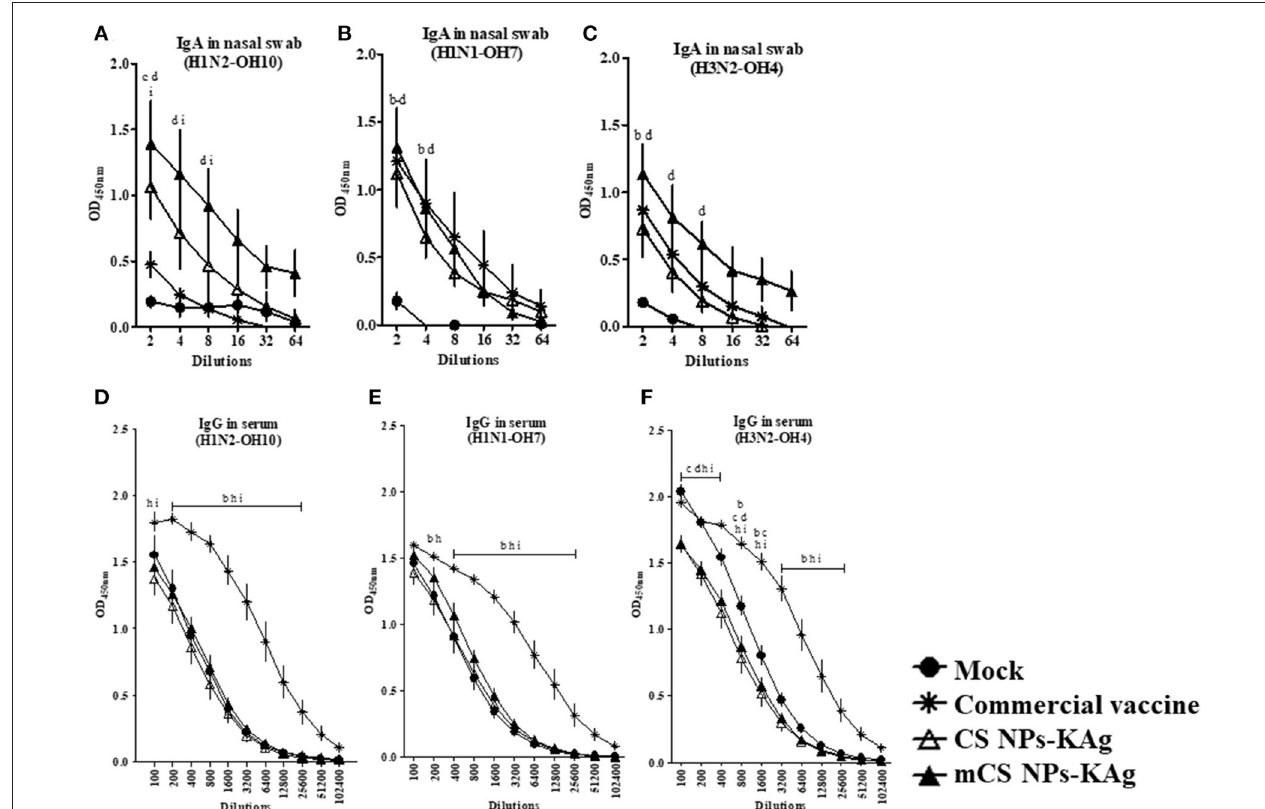
FIGURE 1 | Mannose conjugated CS NPs based influenza (mCS NPs-KAg) vaccine augmented cross-reactive secretory IgA while the commercial flu vaccine boosts specific IgG antibodies in MDA-positive pigs. Pigs were vaccinated twice with mCS NPs-KAg or CS NPs-KAg vaccines (containing H1N2-OH10 virus) intranasally or commercial vaccine (containing H1N1, H1N2 and H3N2 viruses) intramuscularly. On the day post vaccination 35 nasal swab and blood samples collected were subjected to antibody analysis. Secretory IgA antibody response in nasal swab against (A) H1N2-OH10; (B) H1N1-OH7; and (C) H3N2-OH4 viruses, and IgG antibody response in serum against (D) H1N2-OH10; (E) H1N1-OH7; and (F) H3N2-OH4 viruses were analyzed by ELISA. Data represent the mean value of three to four pigs ± SEM at all indicated dilutions. Statistical analysis was carried out using two-way ANOVA followed by a Bonferroni test. Each letter on the line graph indicates the significant difference between the groups at the marked sample dilution: b, c and d indicate the difference between mock group compared to commercial vaccine, CS NPs-KAg, and mCS NPs-KAg, respectively; h and i indicate the difference between commercial vaccine compared to CS NPs-KAg and mCS NPs-KAg, respectively. A p < 0.05 was considered statistically